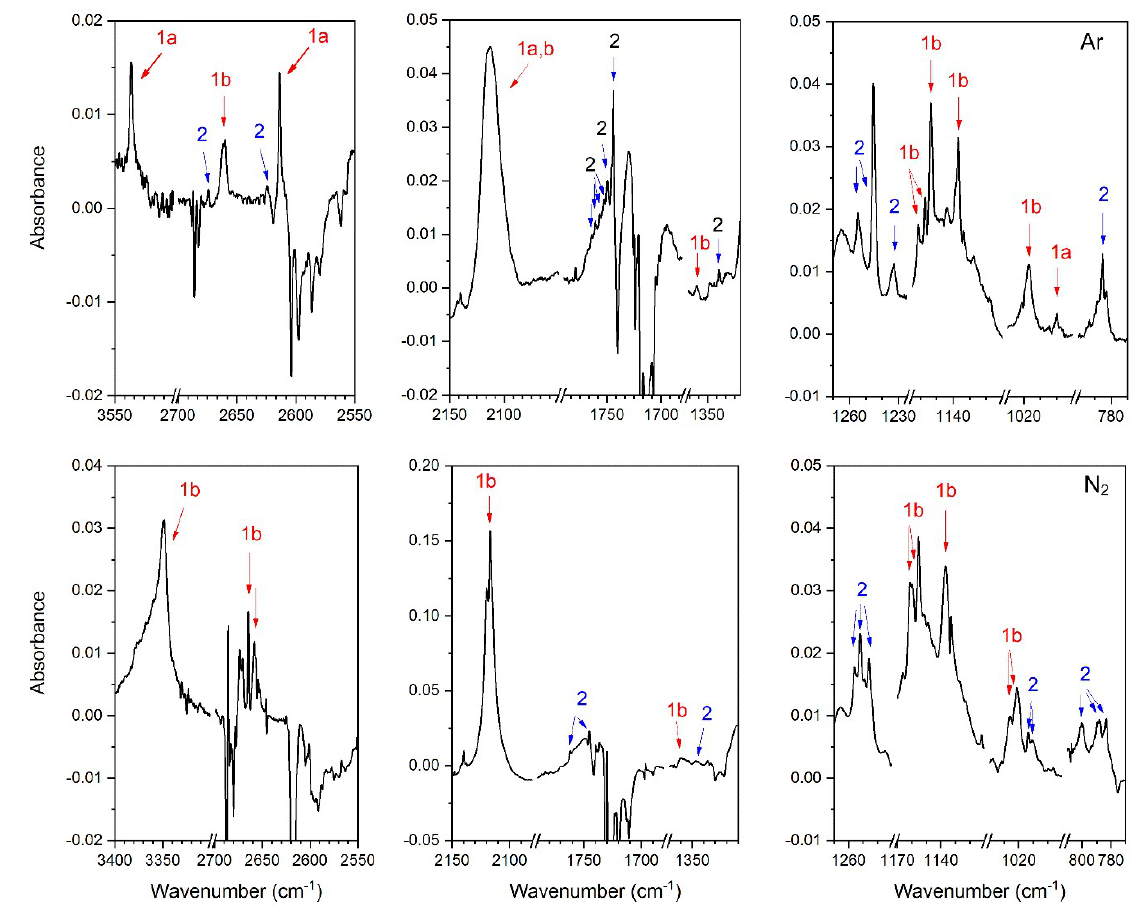
Figure 5. Selected regions of the difference spectrum of the CHOCHO/ND 2 OD/Ar(N 2 ) matrix after 90 min of irradiation minus the freshly deposited CHOCHO/ND 2 OD/Ar(N 2 ) matrix.